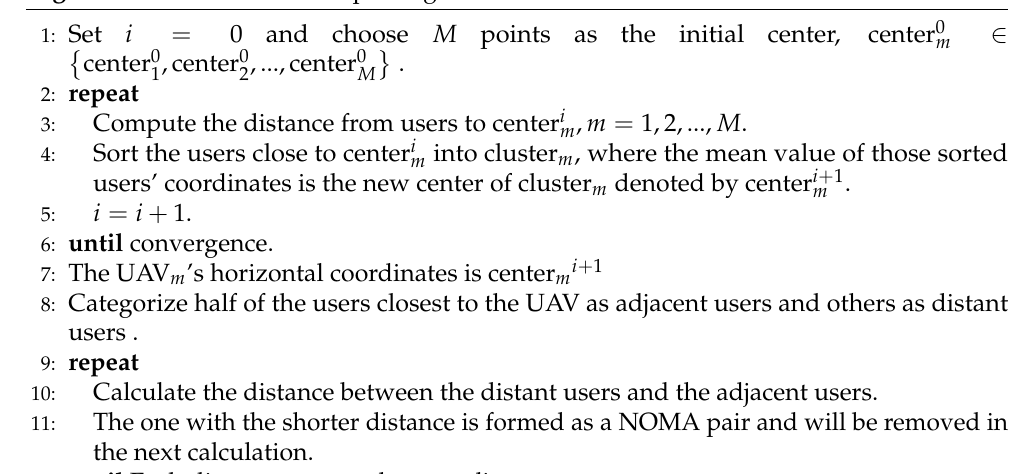
Algorithm 1 K-means cluster pair